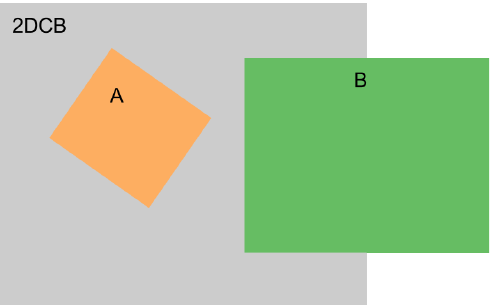
Figure 2. An example of 2D cropped box (2DCB) with two objects box A and box B. All these boxes are square. A has length 1, B has length 2, and 2DCB has length 3. Half of B is overlapped with 2DCB.